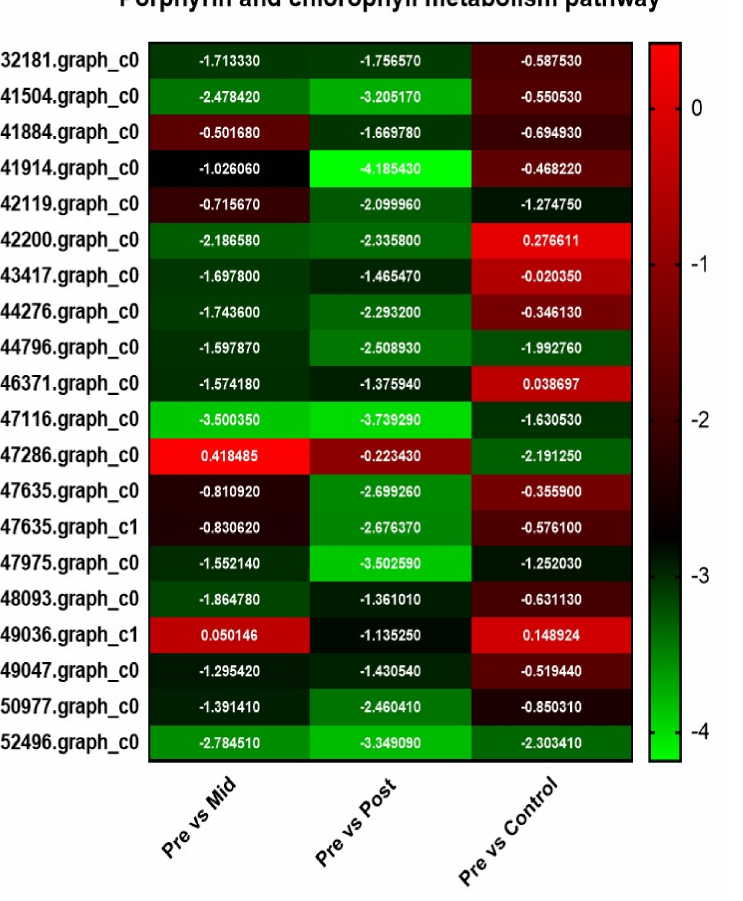
Figure 5. Heat map of DEGs of porphyrin and chlorophyll metabolism pathway in the water dropwort stem under ‘pre vs. mid–blanching’, ‘pre vs. post–blanching’, and ‘pre vs. control’ conditions. Scale represents the expression level of genes ranging from green (downregulation) to red